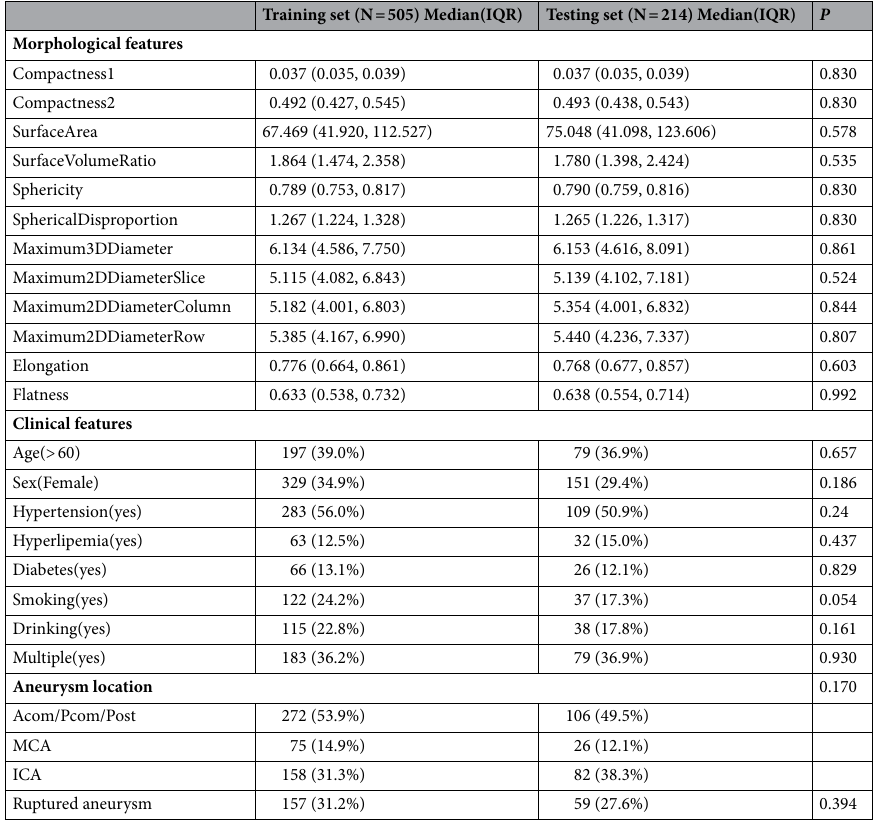
Table 1. Comparison of the features between the training and testing set. IQR interquartile range, Acom anterior communicating artery, Pcom posterior communicating artery, Post posterior circulation, MCA middle cerebral artery, ICA internal carotid